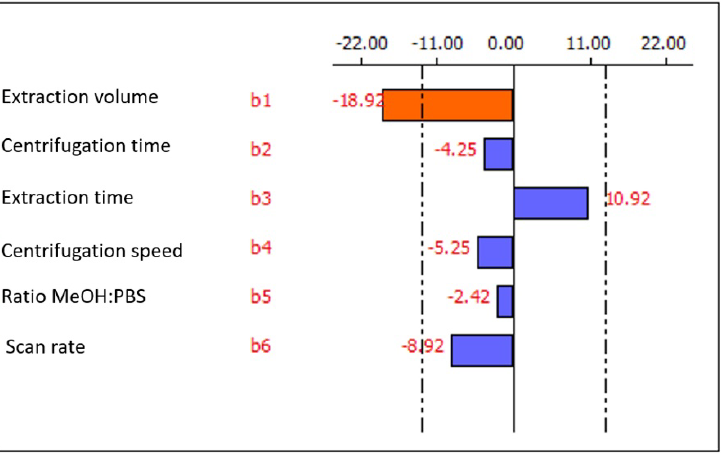
Figure 2. Pareto chart obtained in the Plackett-Burmann screening study.